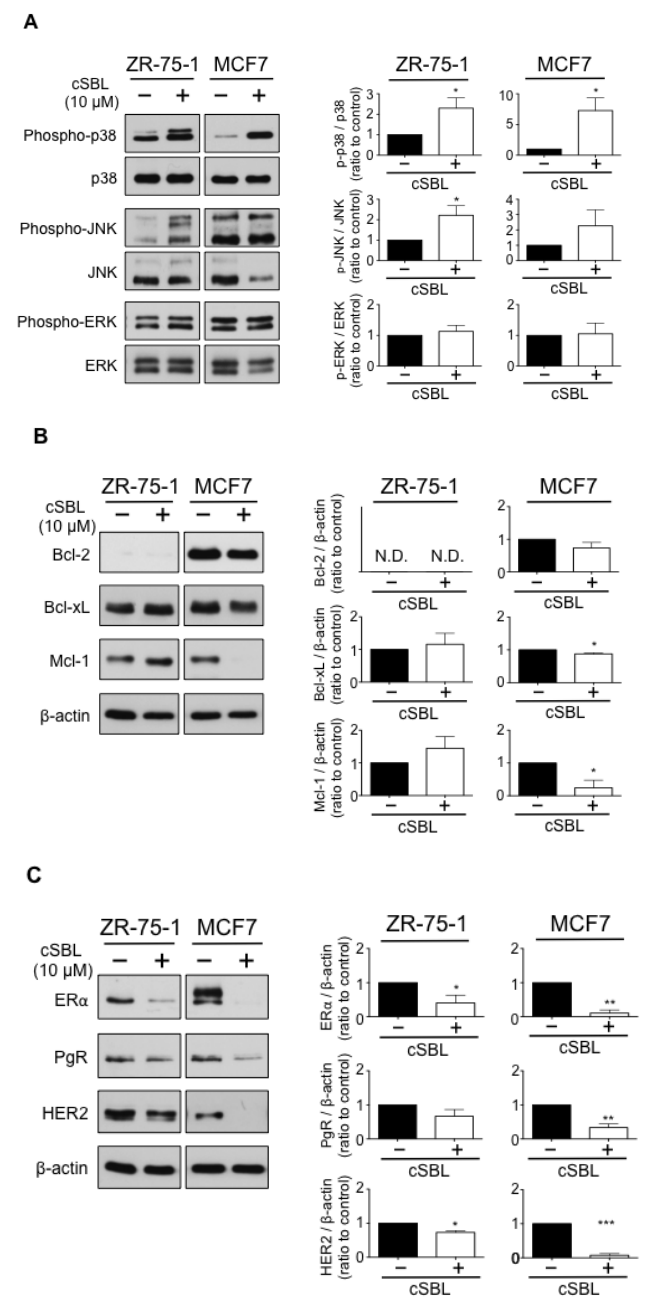
Figure 3. Effects of cSBL on the activations of mitogen-activated protein kinases (MAPKs) ( A ), and expressions of the anti-apoptotic Bcl-2 family ( B ), and breast cancer-related proteins ( C ) in ZR-75-1 and MCF7 cells. Cells were treated with cSBL (10 µ M) for 72 h, and the phosphorylation and expression levels of each molecule were detected by western blotting. The values relative to the controls are presented as the mean ± SD of three independent experiments (right graphs). * p < 0.05, ** p < 0.01, *** p <